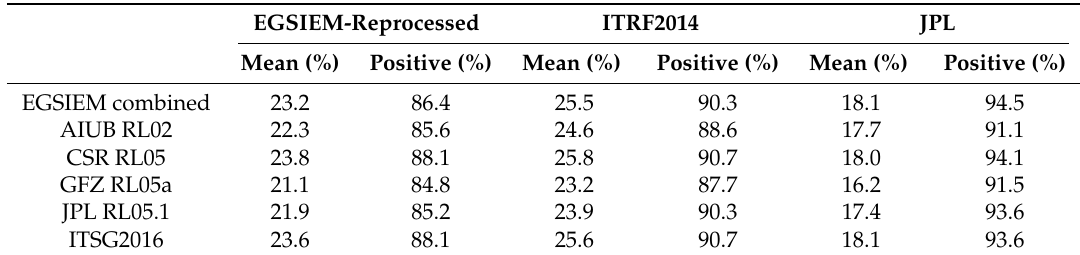
Table 3. Mean and positive WRMS reductions between six GRACE products and three GNSS datasets at the full signal level over 236 common